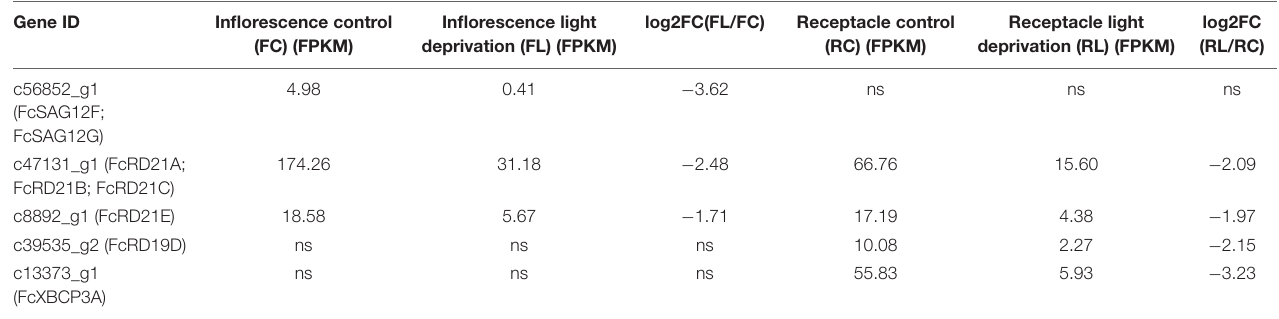
FIGURE 6 | Differentially expressed PLCP genes upon ethephon treatment. Genes were defined as differentially expressed by p -adjust < 0.05 and | log2(fold change)| ≥ 1. Numbers represent log2(fold change). Inflorescences treated with ethephon for 2, 4, and 6 days: E2F, E4F, and E6F, respectively; receptacles treated with ethephon for 2, 4, and 6 days: E2R, E4R, and E6R, respectively. Control inflorescence and receptacles on days 2, 4, and 6: C2F, C4F, C6F, C2R, C4R, and C6R, respectively. TABLE 5 | Differentially expressed PLCP genes in fig fruit subjected to light